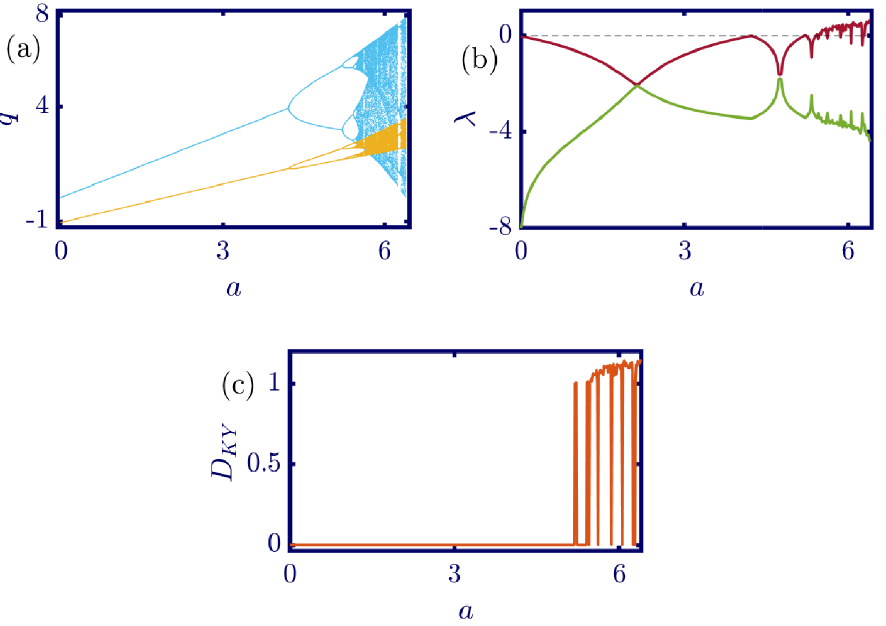
Fig 3. Eq (13) dynamics concerning parameter a with b = 0.5, c 1 = 2, c 2 = 1, d 1 = 0.5, d 2 = 1, v 1 = 0.1, v 2 = 1 and initial conditions